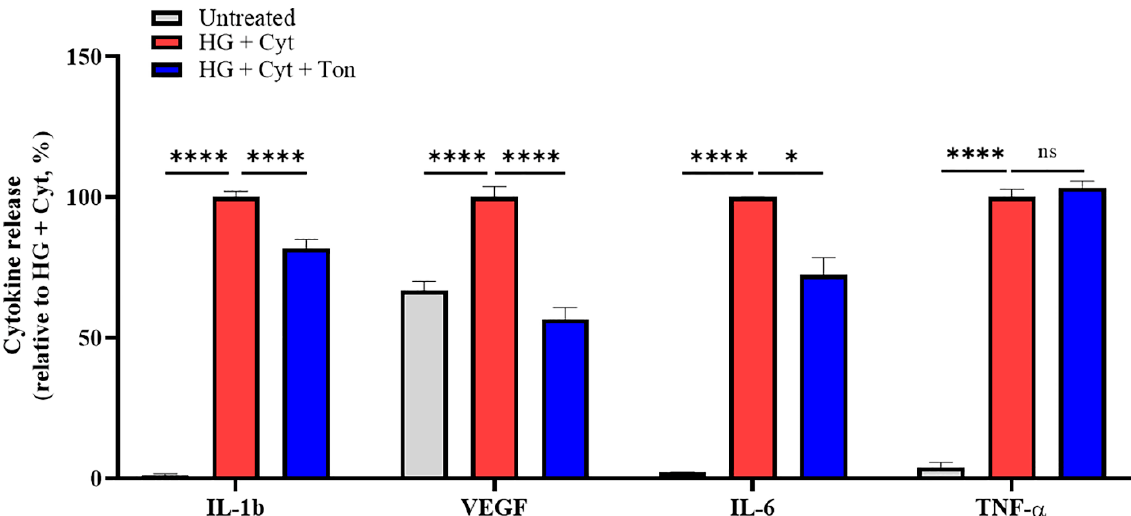
Figure 2. Effect of tonabersat treatment on HG + Cyt-induced proinflammatory cytokine release. All four cytokines, IL-1 β , VEGF, IL-6, and TNF- α , were significantly increased following HG + Cyt treatment in comparison to untreated conditions at 24 h (there was no IL-1 β prior to the challenge). Tonabersat treatment (HG + Cyt + Ton) significantly reduced IL-1 β , VEGF, and IL-6 but not TNF- α levels relative to the HG + Cyt group. Data are presented as mean + SEM. Statistical analysis was carried out using one-way ANOVA with Dunnett’s multiple comparisons test. ns p > 0.05; * p < 0.05; **** p ≤ 0.0001; n = 3.